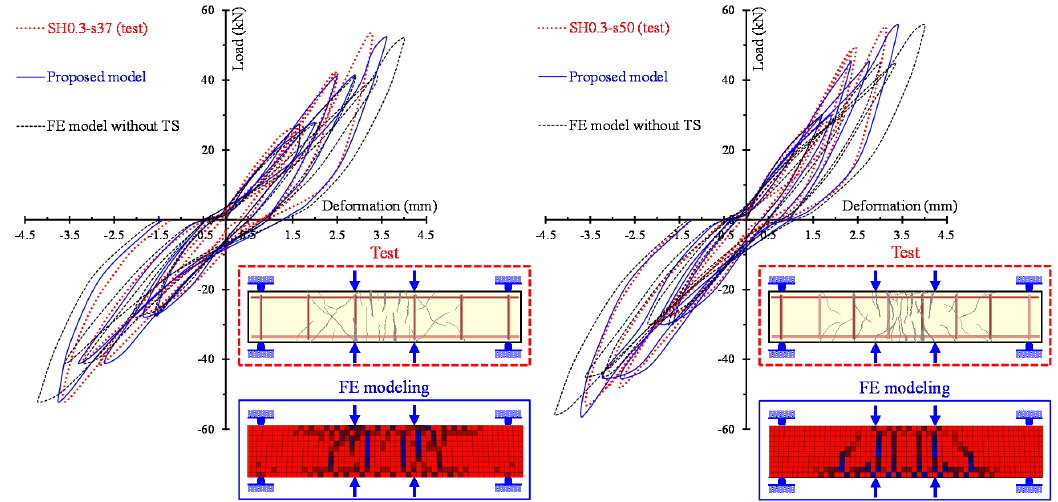
Figure 12. Comparisons between the analytical and experimental hysteretic response and cracking patterns of shear-critical beams with stirrups SH0.3-s37 and SH0.3-s50.